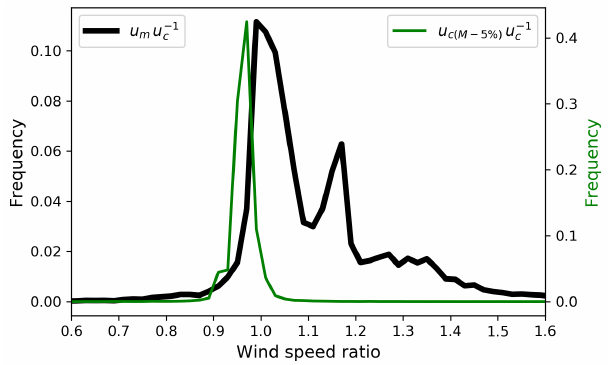
Figure B3. Histogram of the wind speed ratios u m u − 1 c (average of port and starboard measurements). Also shown is the relative change in the corrected u c estimate for a change of − 5% in the reference wind speed (simulating the effect of a bias in ERA-5).